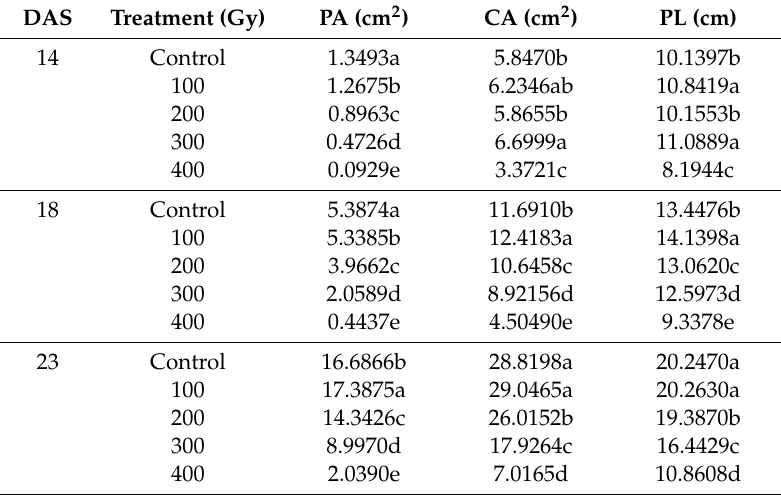
Table 1. Comparison of multiple digital phenotyping measurements at four doses of gamma rays on multiple days after sowing (DAS). Values in the same column followed by a di ff erent letter are significantly di ff erent ( p < 0.05). PA: projected area, CA: convex hull area, PL: perimeter length.